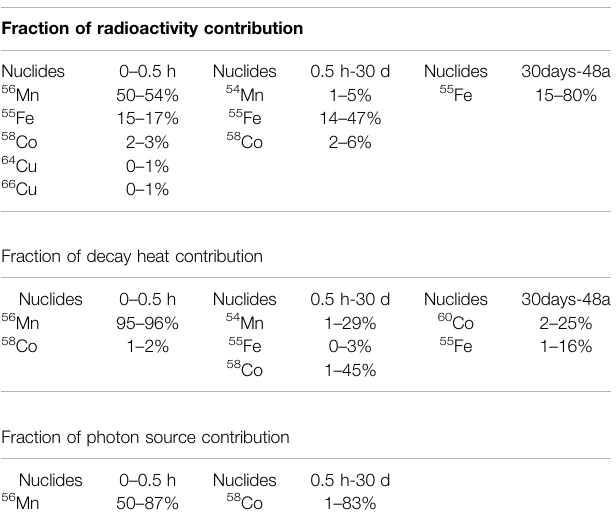
TABLE 3 | The nuclides with large contributions to radioactivity, decay heat and photon source.